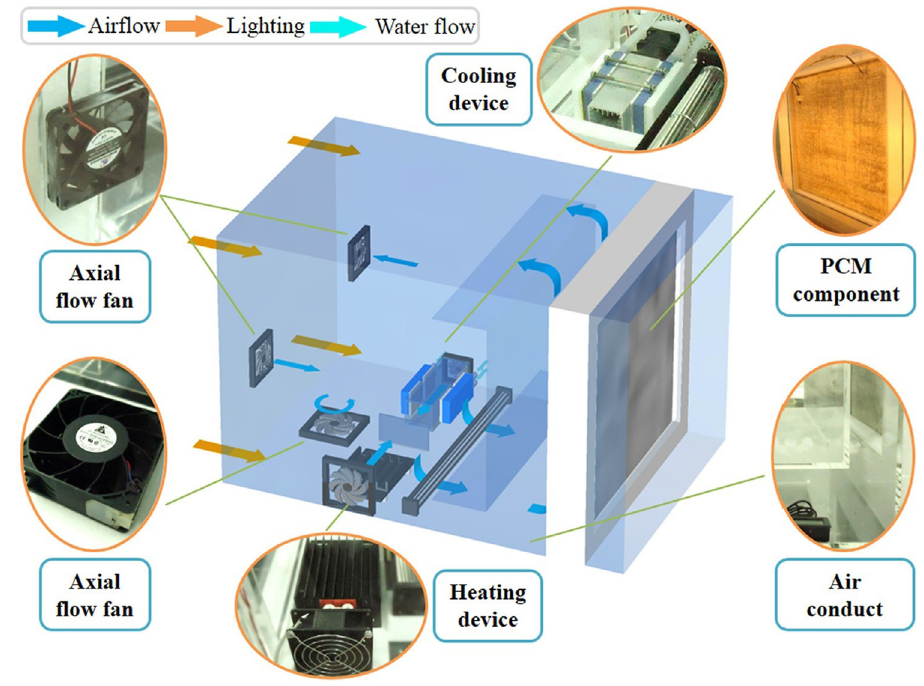
Figure 8: Device setup for calculation of the amount of energy saving in a building wall with polyurea microcapsules addition [ 76 ]